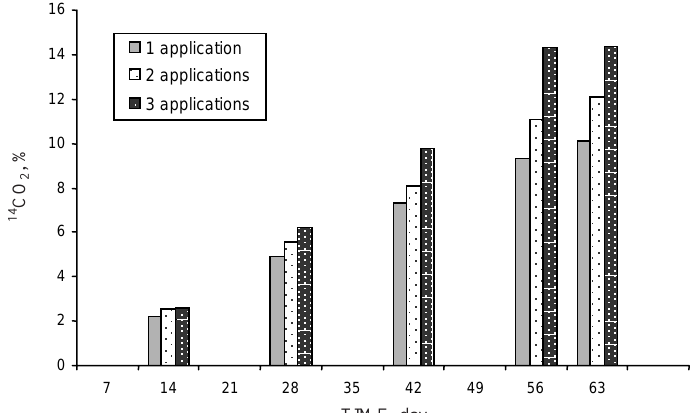
Figure 2. Mineralization of 14 C-metalaxyl after one, two or three successive applications of a commercial formulation of metalaxyl in GH soil samples (cumulative values of 14 CO